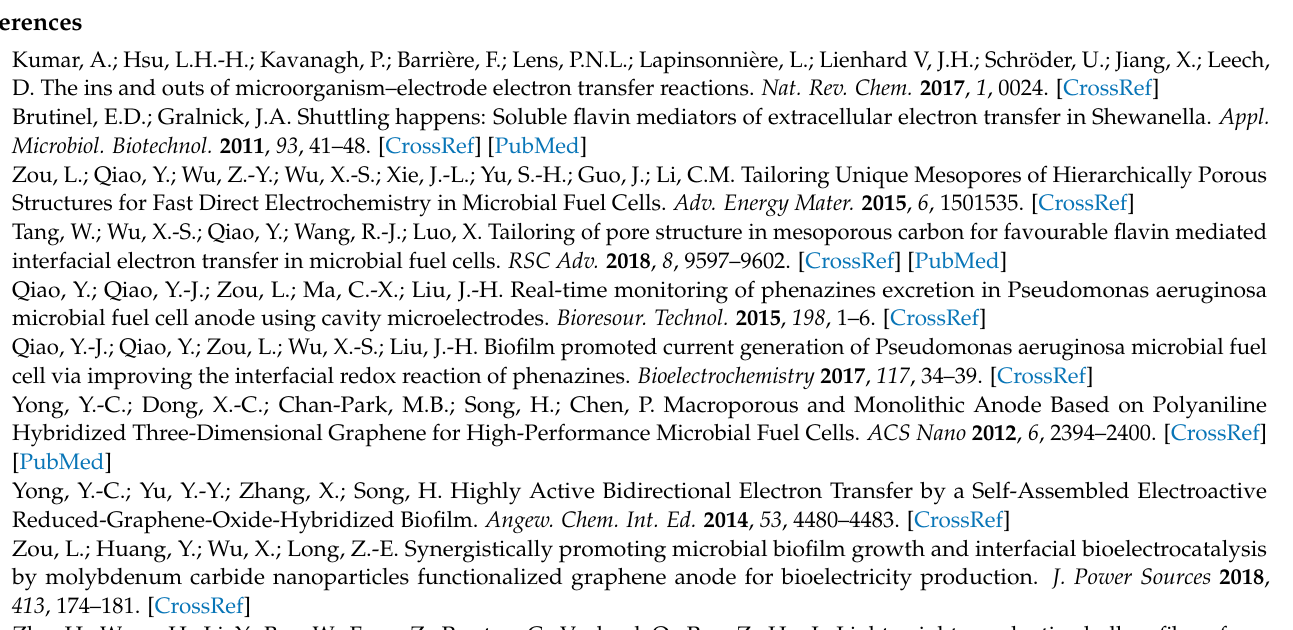
the, Figure S8: Total protein content of the biofilm on CPAN, NPCF-1, NPCF-2 and NPCF-3, Figure for NPCF-3 anode, Figure S10: Dual-chamber MFC device, Table S1: Summary of the diameter, bulk density, ID/IG ratio and power density of different carbon fiber